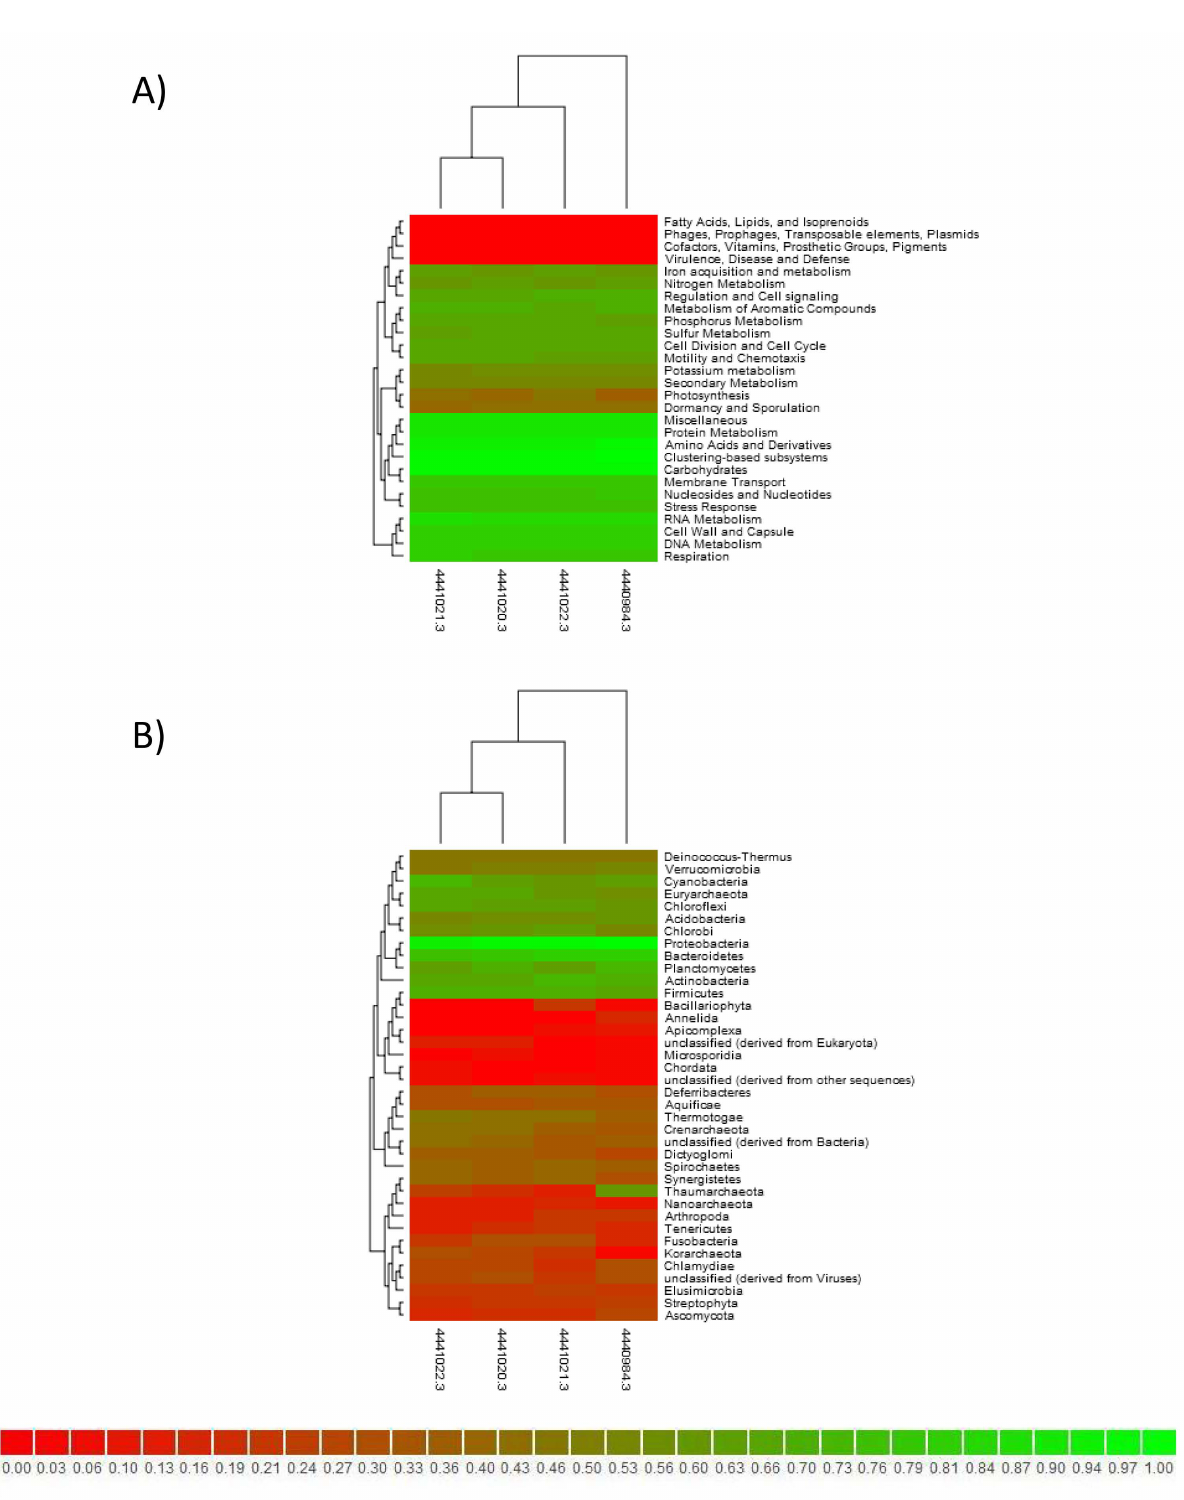
Fig. 1. Disimilarity between metagenomic profiles. (A) Functional potential (B) Taxonomic composition. 4440984.3 = 37, 4441020.3 = 109, 4441021.3 = 132, 4441022.3 = 136. Colour gradient represents proportion of